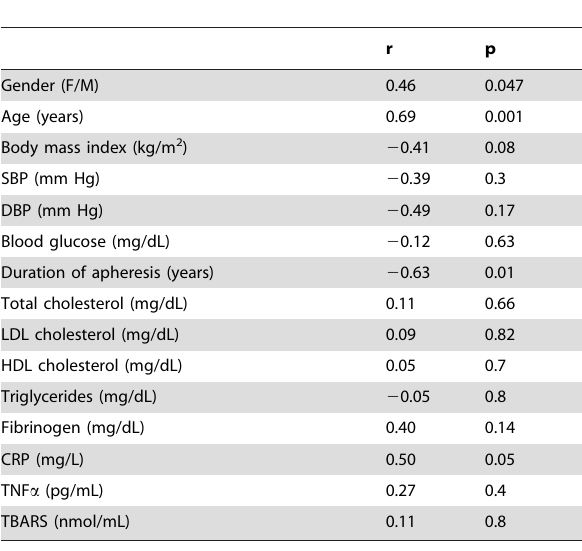
Table 2. Univariate analysis of plasma baseline PTX3 with anthropometric and laboratory parameters in FH